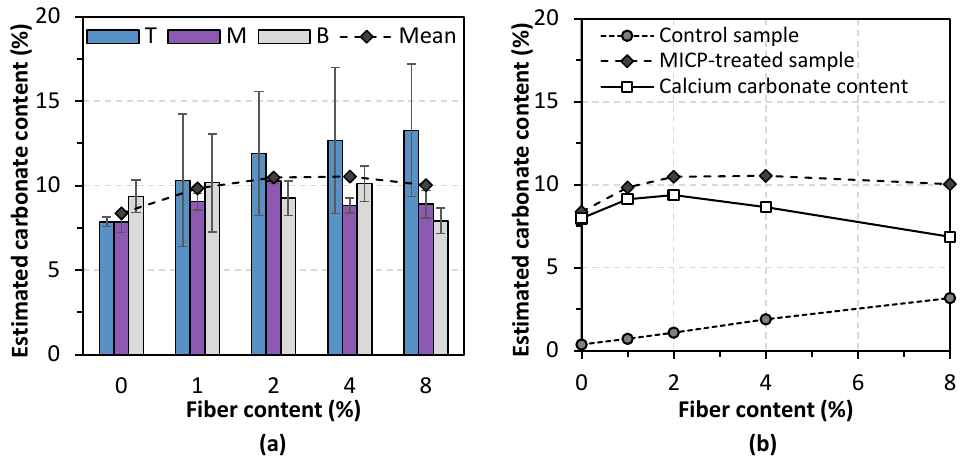
Figure 7. Estimated calcium carbonate content of MICP-treated samples: ( a ) carbonate content from different depths; ( b ) estimated carbonate content.